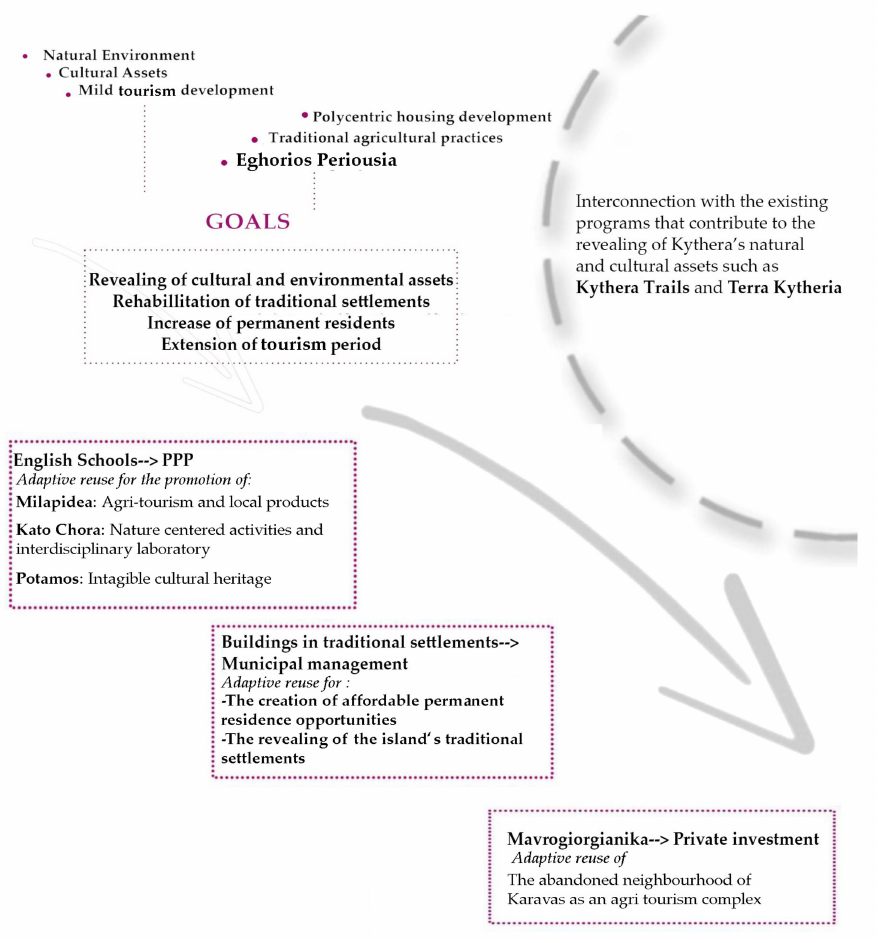
Figure 30. Flowchart summarizing the proposal schemes for